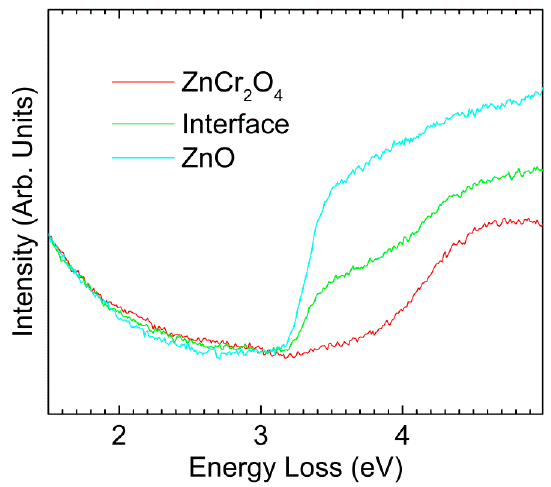
Figure 3. EELS spectra of ZnCr 2 O 4 , ZnO and the interface position.